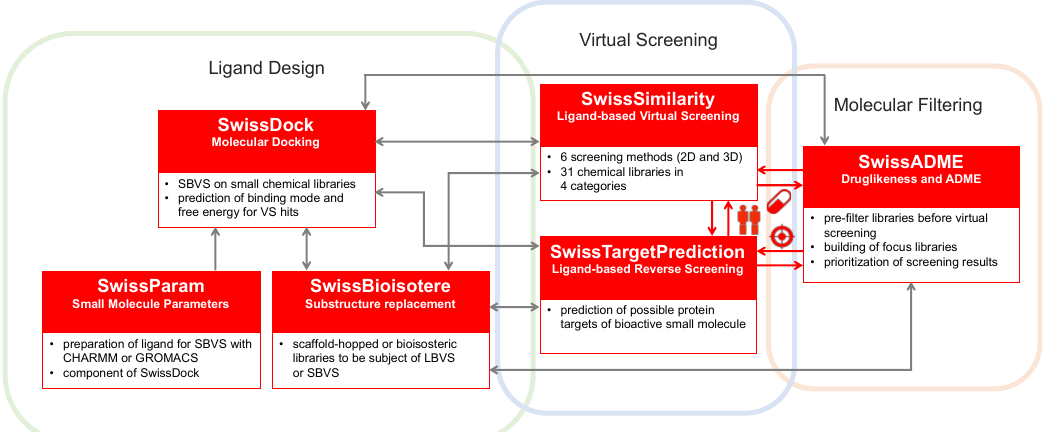
Figure 1. Virtual screening applications of the different on-line tools of the SwissDrugDesign project (boxed in red). Grey arrows represent “soft” relationships, for which the output of one tool can be the input of another tool by means of some user manipulation (e.g., copy/paste of SMILES). Red arrows represent actual interoperability capacities. In this way, submission of the result of one tool is simply achieved by “one-click” on the icon corresponding to the desired tool: “twins” for SwissSimilarity, “target” for SwissTargetPrediction and “pill” for SwissADME.